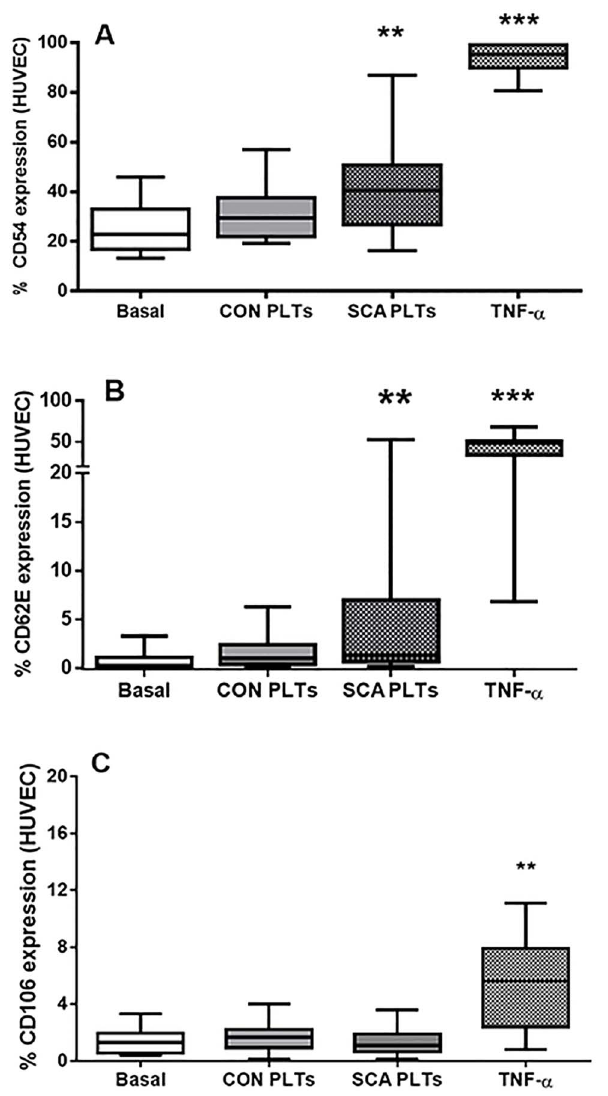
Figure 3. Effects of platelets on endothelial adhesion molecule expression. Surface expressions of (A) ICAM-1 (CD54), (B) E-selectin (CD62E) and (C) VCAM-1 (CD106) adhesion molecules on HUVEC following co-culture in direct contact with healthy control (CON; N $ 15) PLTs, steady-state sickle cell anemia (SCA; N $ 25) PLTs or TNF- a (N $ 11). HUVEC (1 6 10 6 cells/well) were incubated with CON or SCA PLTs (1 6 10 8 PLTs/well) for 4 h (37 u C, 5% CO 2 ), or with TNF- a , (10 ng/ml; 3 h, 37 u C, 5% CO 2 ). Expression of ICAM-1, E-selectin or VCAM-1 was analyzed on HUVEC (10 000 cells) by flow cytometry using anti-CD54- PE, CD62E-APC and CD106-FITC. **, p , 0.01; ***, p , 0.001, compared to basal (N $ 16).